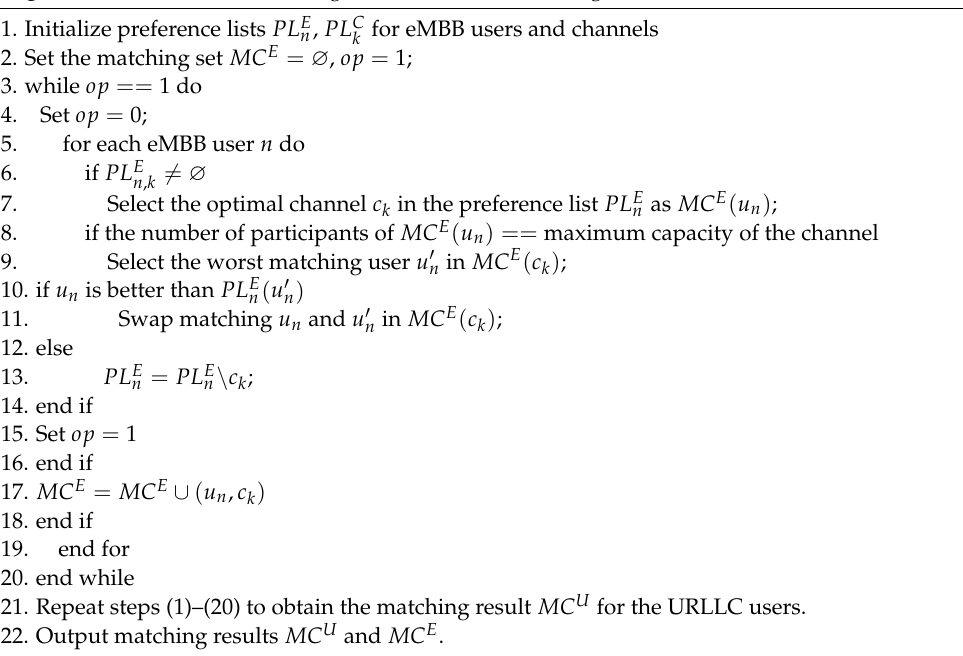
Algorithm 1 Channel selection algorithm based on